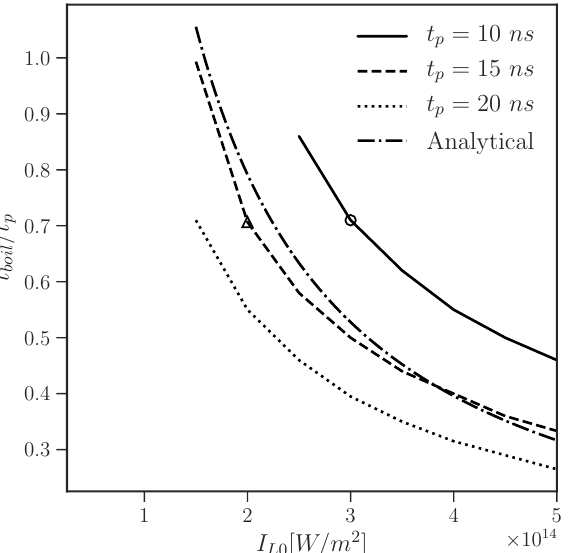
Figure 9. Time required to reach boiling temperature normalized by FWHM against the peak laser intensity. Analytical results are normalized for t p = 15 ns. Symbols show results for two cases with same integrated intensity but different